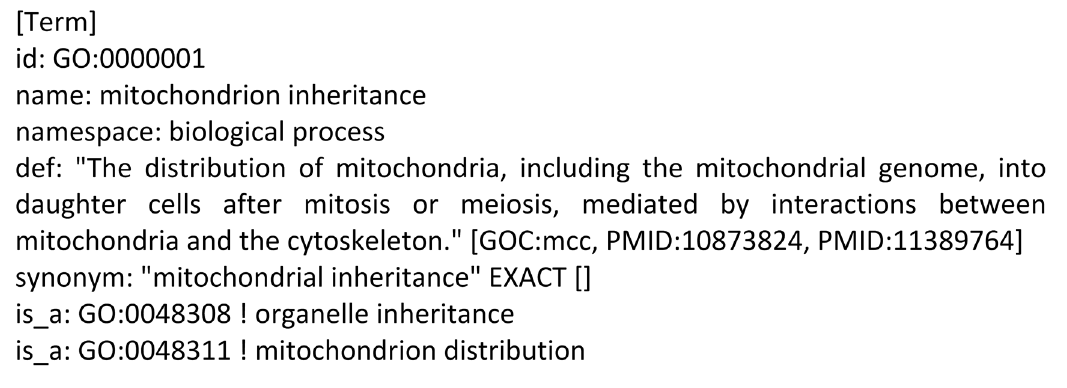
Figure 2. The file format of the Gene Ontology.